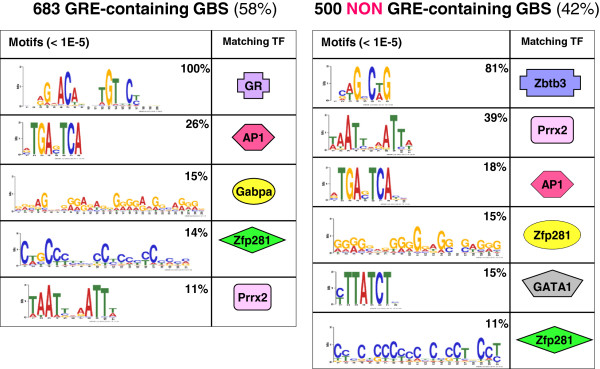
MEME de novo motif discovery within GBS. A. Motifs for transcription factor binding in the 683 GBS that contain a GRE-like sequence. B. Motifs for transcription factor binding in the 500 GBS without a GRE. Analysis was performed within a 200 bp-frame containing the GBS-centre in the middle. The frequency of identified motifs in the PC12-dataset is indicated as well as transcription factors of which the known binding motif most significantly matches the identified motif. Only motifs with an E-value < 1E-5 are depicted.